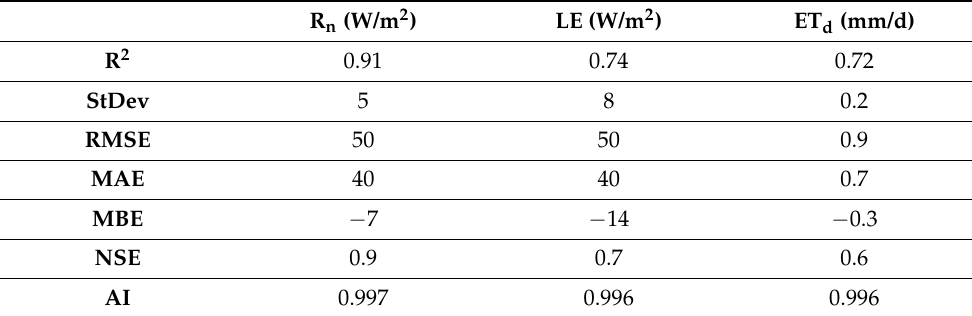
Figure 4. Comparison of daily evapotranspiration (ET d ) estimated from field data at both sites, with the ET d retrieved from data acquired by Landsat-8 OLI/TIRS, after applying the S-SEBI model. Table 1 shows the statistical results for the analysis of the ground-model differences for R n and LE fluxes, as well as ET d values, retrieved with Landsat-8 data. Results compared with field reference values presented a relatively high correlation (with R 2 from 0.72 to 0.91) and